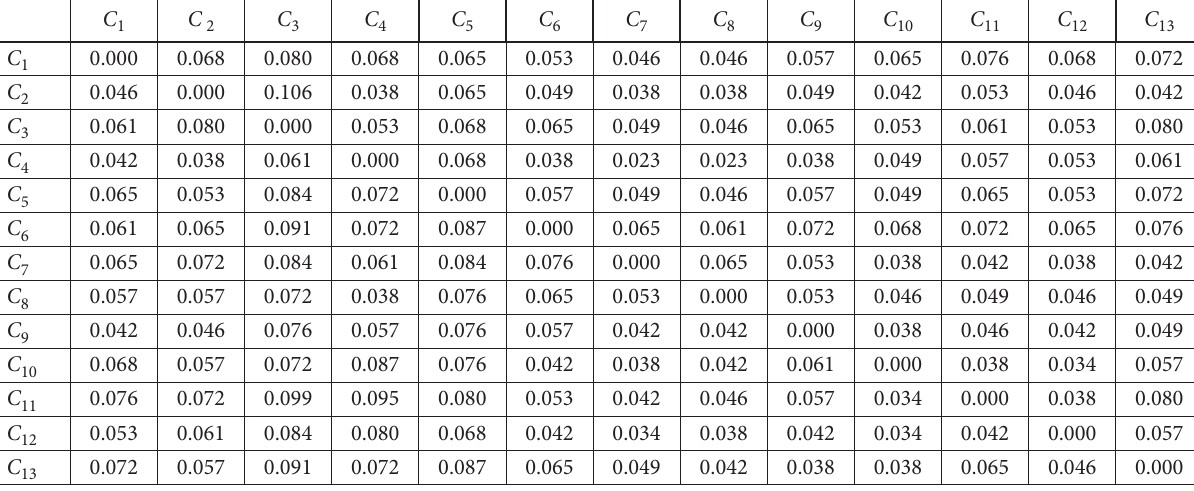
Table 5. Normalized influence relation matrix